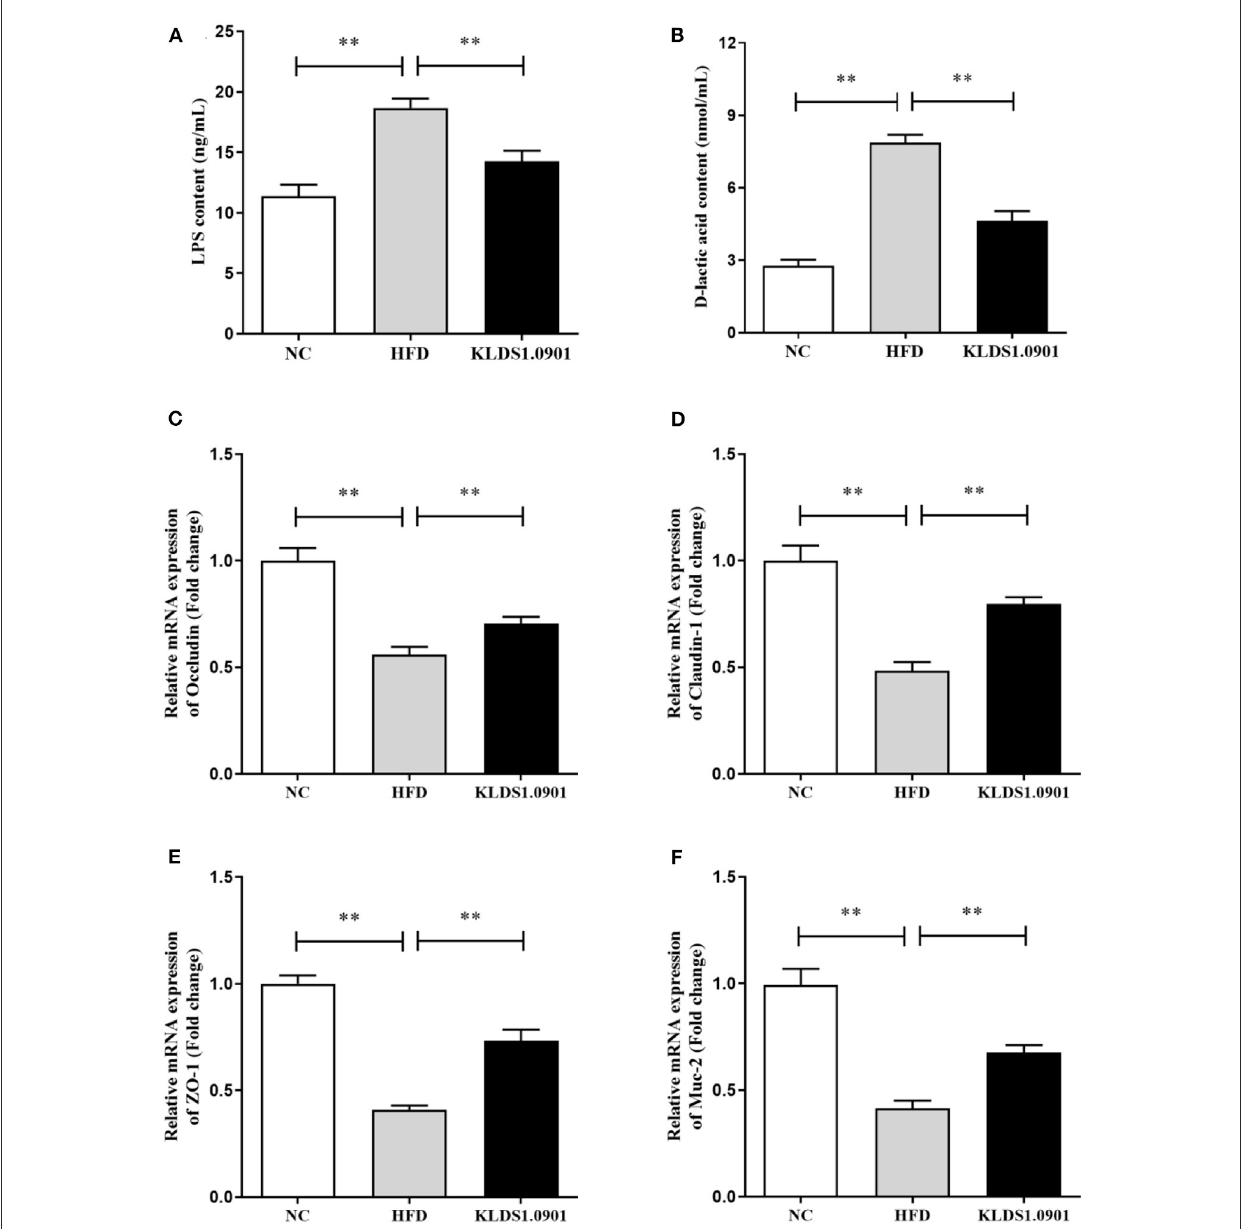
FIGURE6 Effects of L. acidophilus KLDS1.0901 administration on the intestinal permeability and gut barrier. NC, normal control group; HFD, high-fat diet group; and KLDS1.0901, L. acidophilus KLDS1.0901 group. (A) Serum LPS concentration; (B) serum D-lactic acid concentration; (C) occludin; (D) claudin-1; (E) ZO-1; and (F) Muc-2. Values are expressed as mean ± SD ( n = 8). ** p < 0.01 indicated that there was a significant difference when compared with the HFD